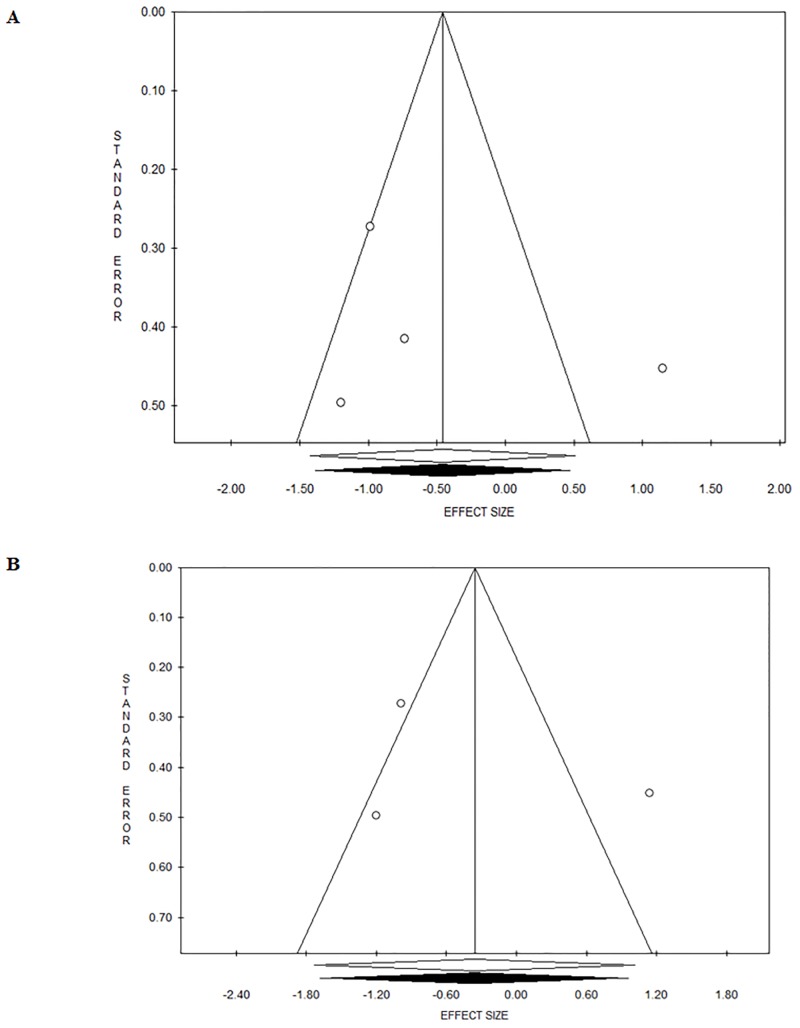
Funnel plot showing evidence of publication bias for the meta-analysis concerning testosterone changes induced by soccer match when pooling all studies, including (5a) and removing (5b) Coelho et al. [29].